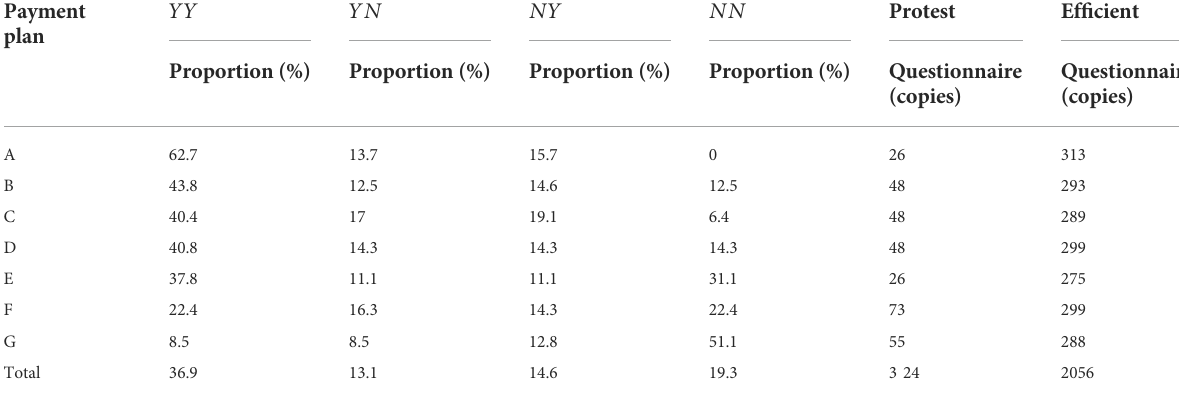
TABLE 3 WTP distribution of the double-bound dichotomous